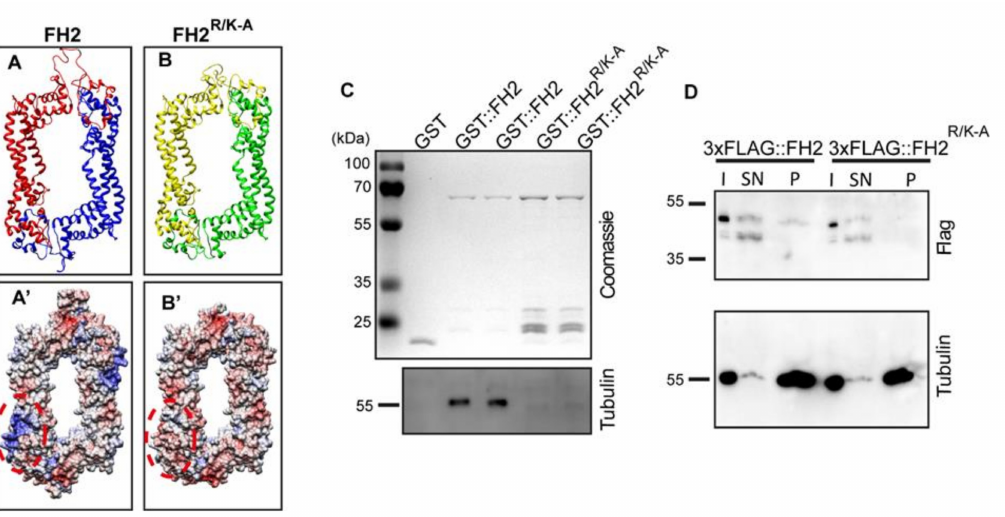
Figure 3. Biochemical characterization of the FH2R/K-A mutant form of DAAM. ( A – B (cid:48) ) Ribbon diagram ( A , B ) and surface charge distribution ( A (cid:48) , B (cid:48) ) of the wild-type and R/K-A mutant FH2 domain of Drosophila DAAM. The region affected by the R/K-A is encircled in red (dashed oval in A (cid:48) , B (cid:48) ). ( C ) A GST-pull down assay, carried out by using GST-tagged wild-type and R/K-A mutant FH2 recombinant proteins in combination with purified tubulin. Eluates of the GST-pull down were analyzed by gel electrophoresis and Western blot. Recombinant proteins were visualized by Coomassie blue staining and bound tubulin was detected by an anti-tubulin antibody. Note